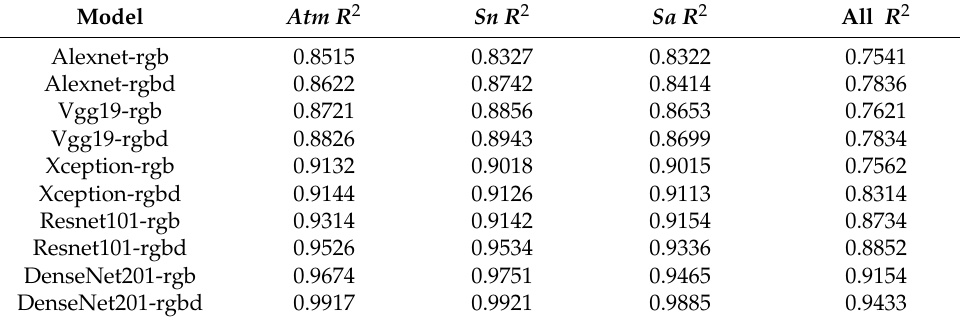
Table 3. Network R 2